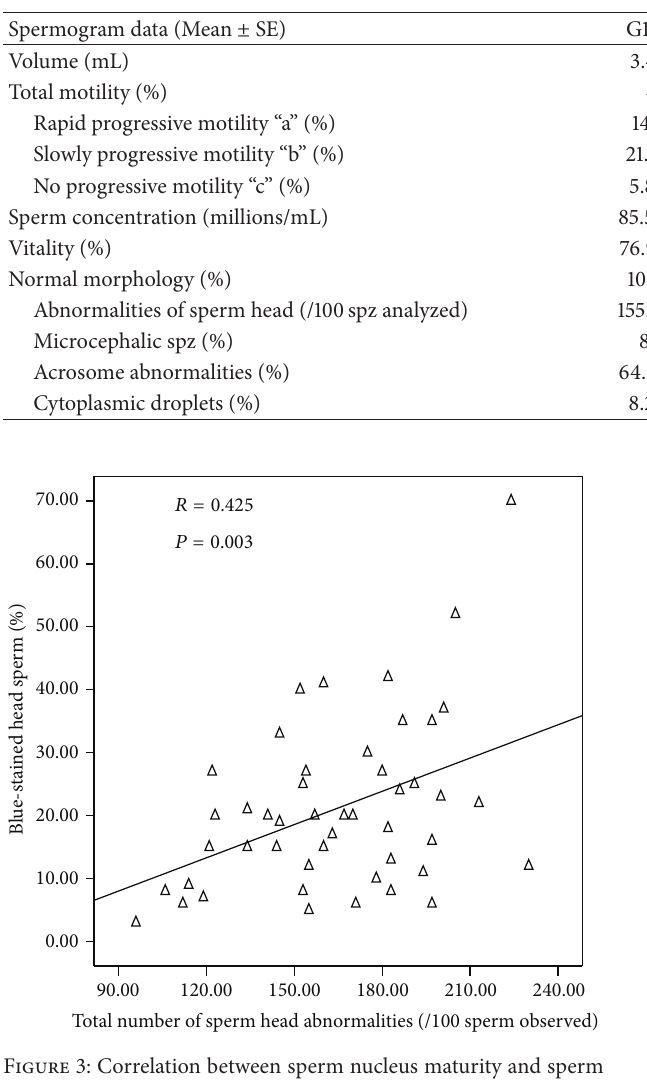
Figure 4: Correlation between sperm nucleus maturity and acro- some